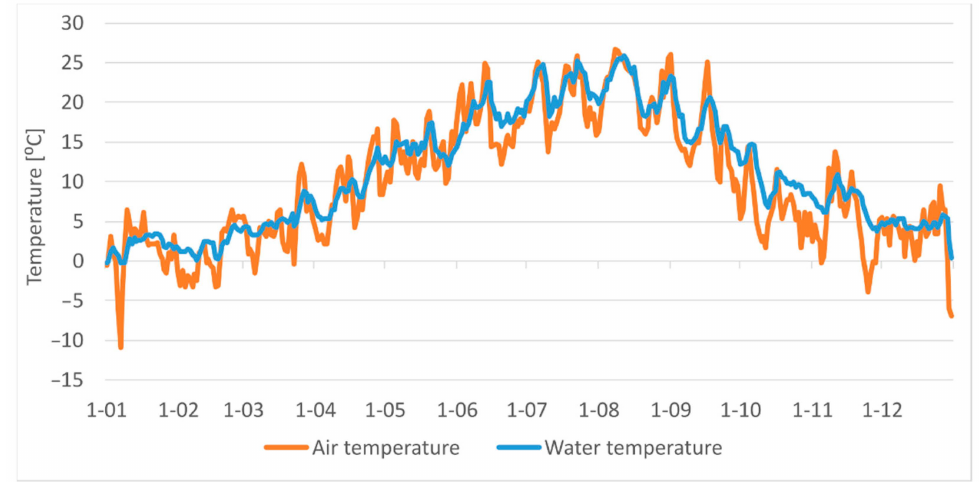
Figure 15. Water temperature diagram in the Wisła River (Szczucin) and air